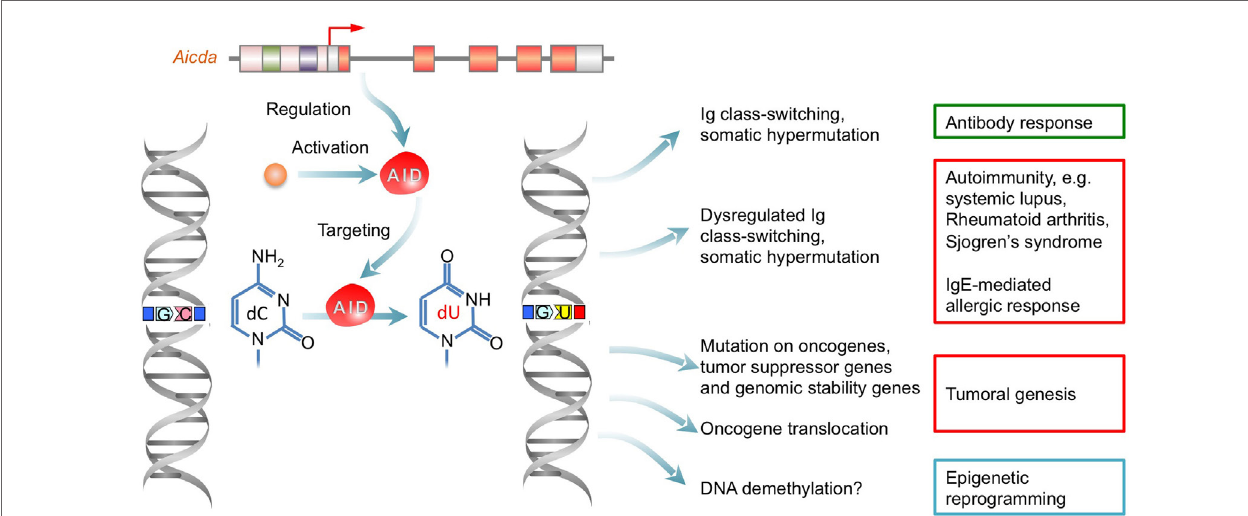
FiGURe 3 | Dysregulation of AiD result in autoantibody-mediated autoimmunity, ige-mediated allergic response and tumoral genesis . AID initiates CSR and SHM by deaminating dCs into dUs yielding dU:dG mismatches, which lead to point-mutations in Ig V(D)J regions and DSBs in S regions. Aberrant AID expression result from epigenetic dysregulation can lead to a dysregulated antibody/autoantibody response and AID-mediated DNA mutagenesis, which can cause autoimmunity, allergic response, or tumoral